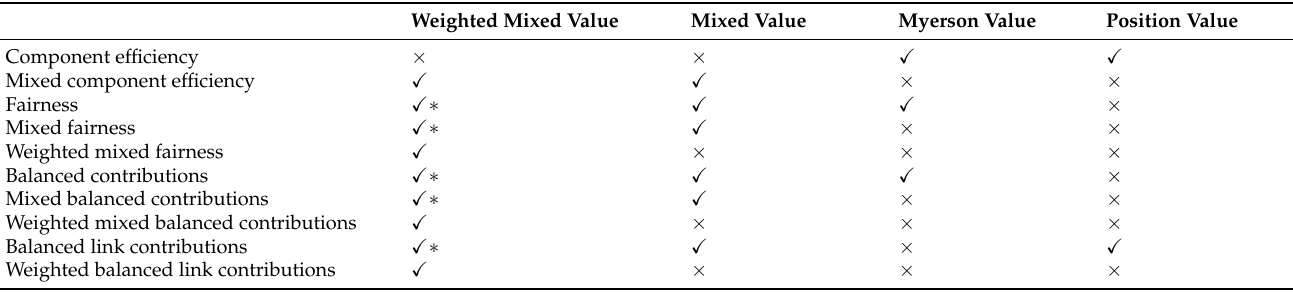
Table 1. Comparison of the properties of the values. Weighted Mixed Value Mixed